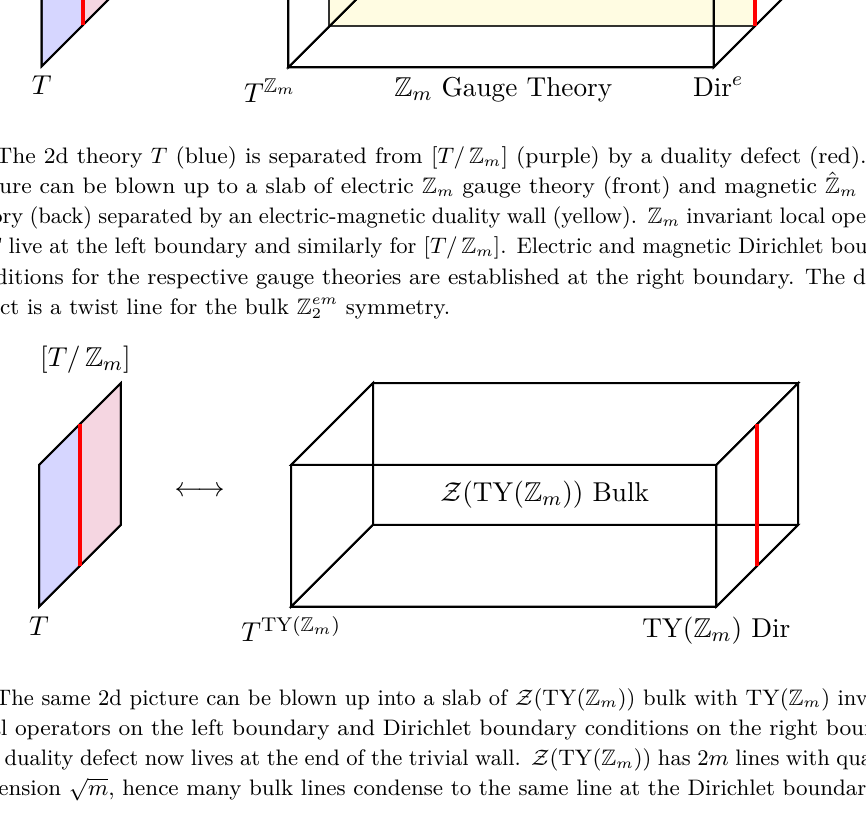
Figure 7 . Two different (2+1)d blow-ups for a theory with a duality defect line inserted. To go from (a) to (b), one must gauge the Z em 0-form symmetry generated by the duality wall I em , with 2 Neumann boundary conditions for Z em on the left and Dirichlet on the right. This makes the duality 2 wall I em “become invisible,” leaving behind the duality defect. To go from (b) to (a), one must gauge the bulk Z em 1-form symmetry of Z (TY( Z m )) 2